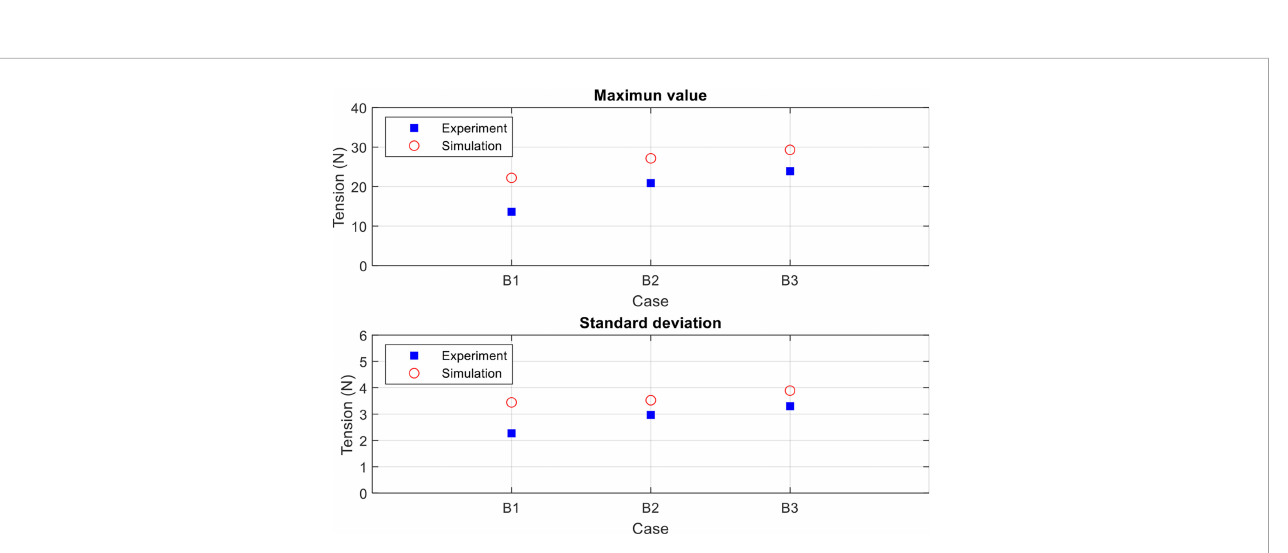
FIGURE 13 In fl uence of the current velocity on the maximum, mean, and minimum values and the standard deviations of the mooring force under the mooring line failure of a net cage in irregular waves and